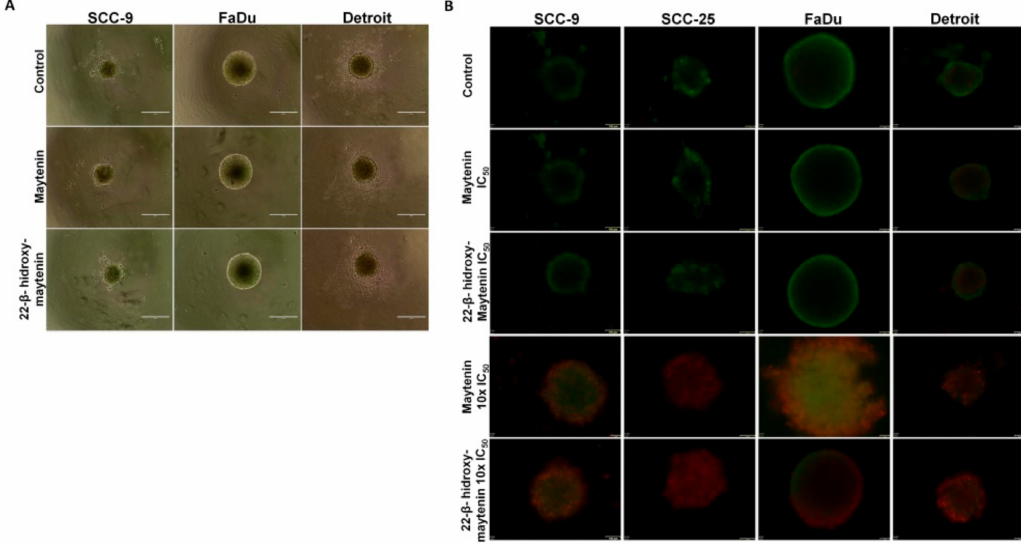
Figure3. Sizeandcellviabilityinmayteninand22- β -hydroxymaytenintreatedspheroids. ( A )Spheroids were treated for 48 h with the corresponding IC 50 obtained in 2D cell culture. No size reduction was detectable using a light microscope for any of the treatments. n = 4. ( B ) Cell viability in the outer layers of the spheroids following treatment with the IC 50 obtained in 2D cell culture and with 10 × the IC 50 obtained in 2D cell culture. n = 4. Live cells fluoresce green, and dead cells fluoresce red. A clear e ff ect on cell viability was observed at the outer cell layer when 10 × the IC 50 was used for every